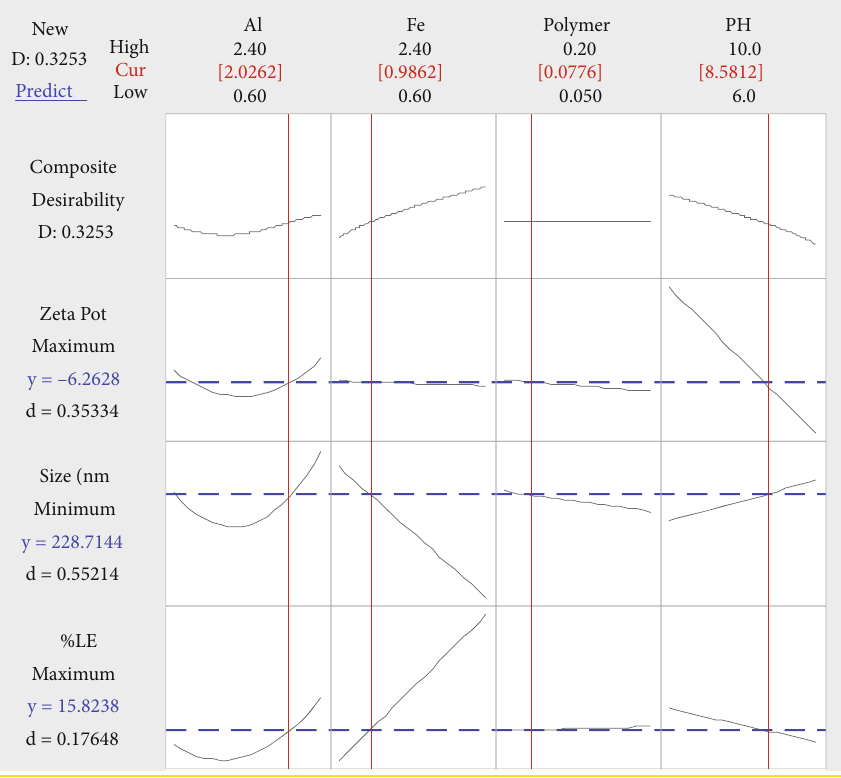
Figure 5: The optimized concentrations for response factors %LE, particle size, and zeta potential. Table 3: Comparative results between observed and predicted response values of variables of optimized formulation. Concentrations Experimental response Predicted values Observed values Bias